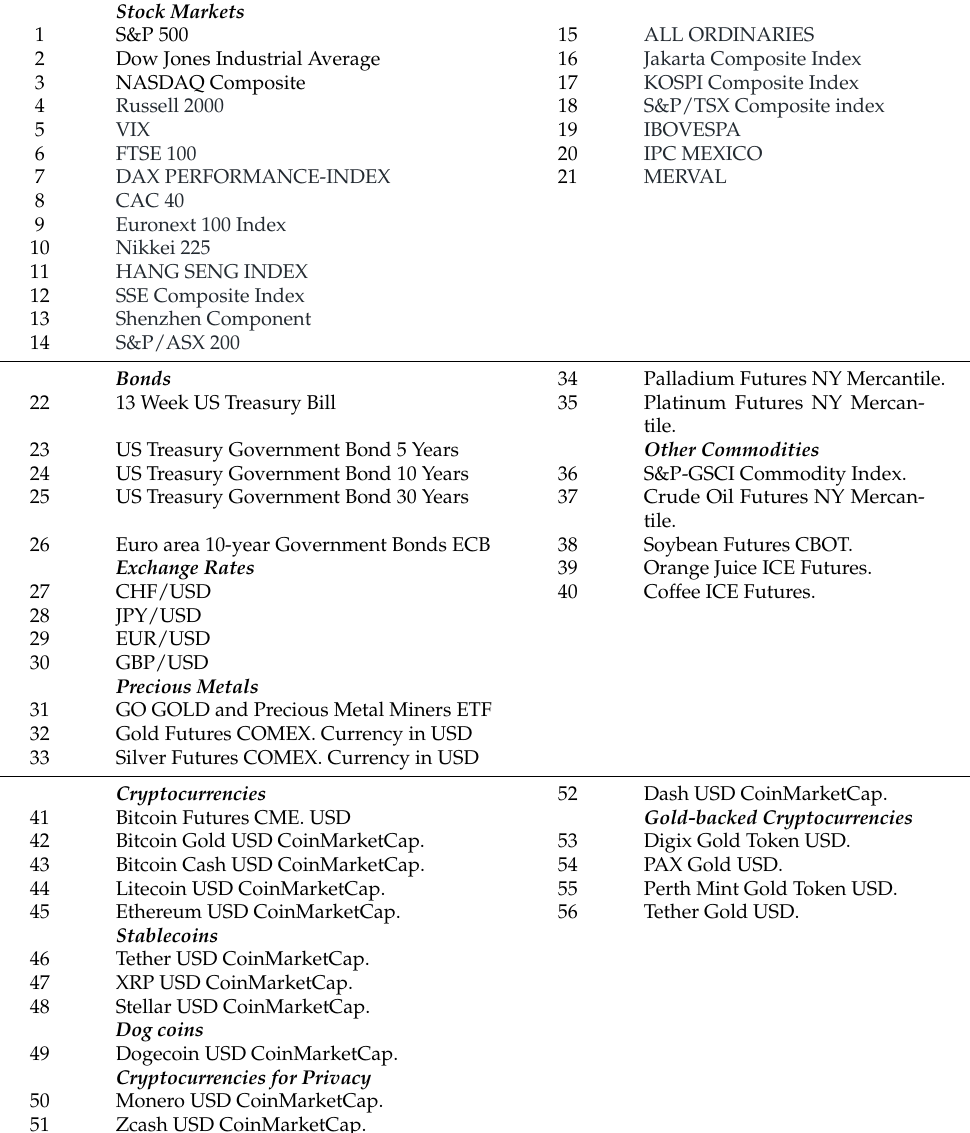
Table 3. A total of 56 assets’ list (benchmark